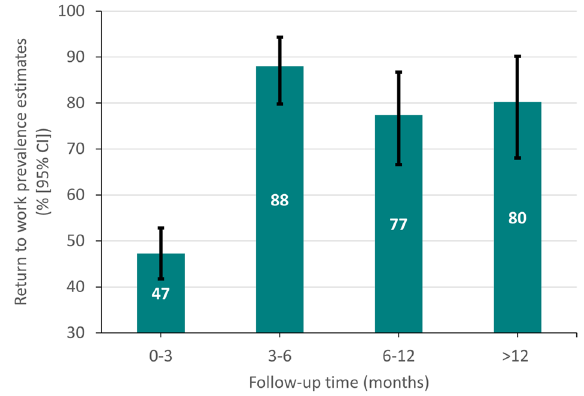
Figure 3. Return-to-work prevalence according to follow-up time.